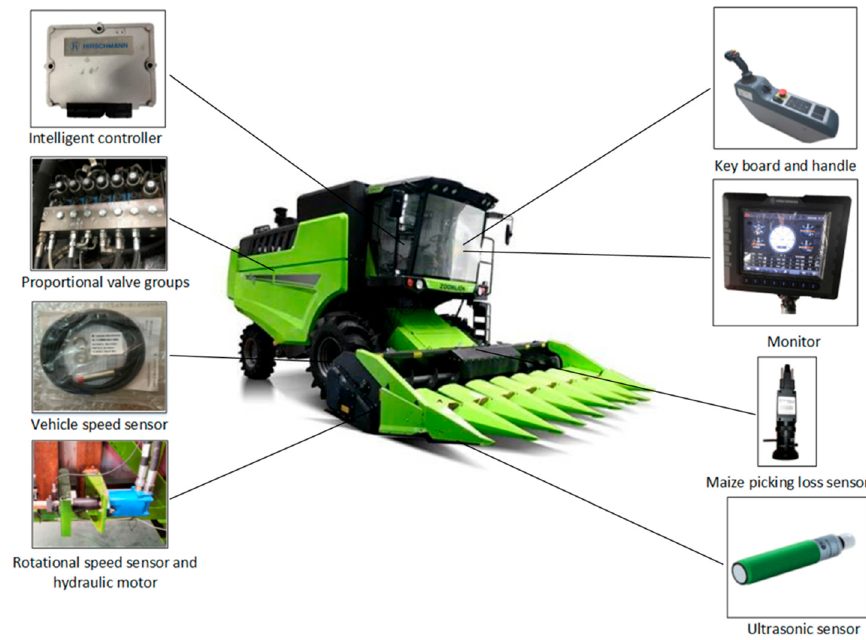
Figure 1. Schematic diagram of intelligent control system.